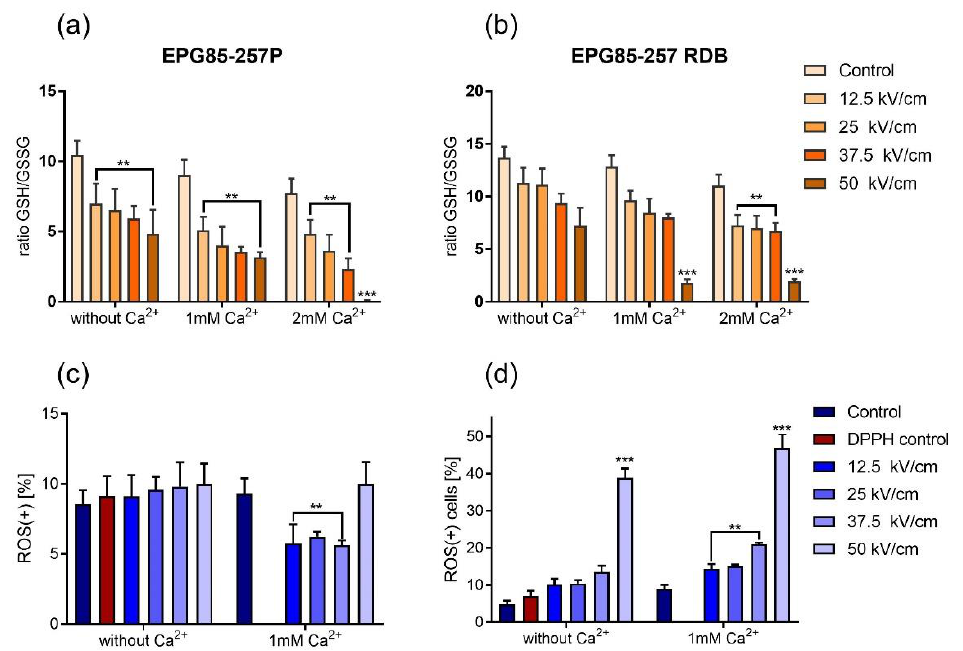
Figure 6. The evaluation of antioxidative and oxidative effects after the exposure of EPG85-257 P and RDB cells to nsPEFs alone or with calcium ions. The ratio of GSH/GSSG in ( a ) sensitive and ( b ) drug-resistant cells. Fluorescent signal detection of reactive oxygen species (ROS) in ( c ) sensitive and ( d ) drug-resistant cells. Data are mean ± SD (n = 3 independent experiments), ** p < 0.05, *** p < 0.005.